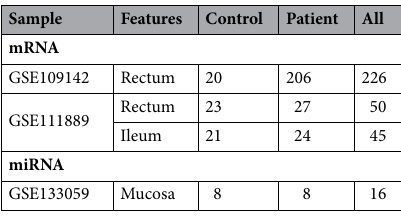
Table 1. UC datasets sample